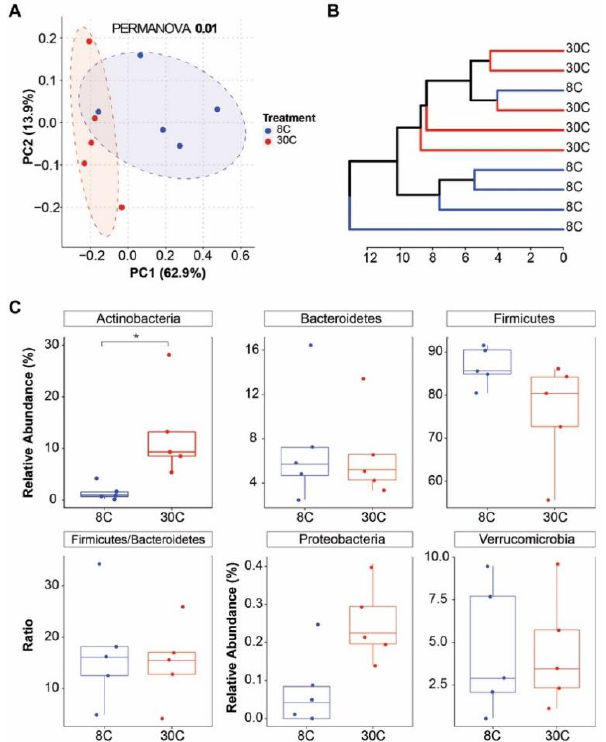
Figure 6. Beta diversity and phylum-level differences from the cecal bacterial community of mice exposed to different temperatures. ( A ) Genus-level principal coordinate analysis plot based on Bray-Curtis dissimilarities. Axes show the first two principal components and their corresponding percentage of variance explained. Ellipses define the 95% confidence level. ( B ) Hierarchical dendro- gram based on Ward’s method displaying clustering by temperature. ( C ) Phylum-level classification of the cecal bacterial community. Mice exposed to either 8 ◦ C (n = 5) or 30 ◦ C (n = 5) for 7 days. Wilcoxon rank sum test (* p <